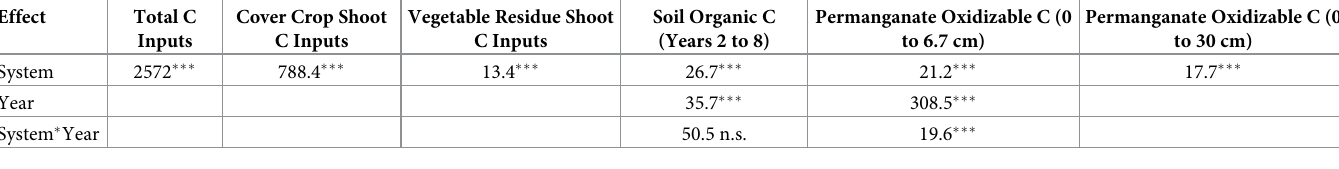
Table 2. Carbon inputs, soil organic carbon and permanganate oxidizable carbon ANOVA F -statistics and